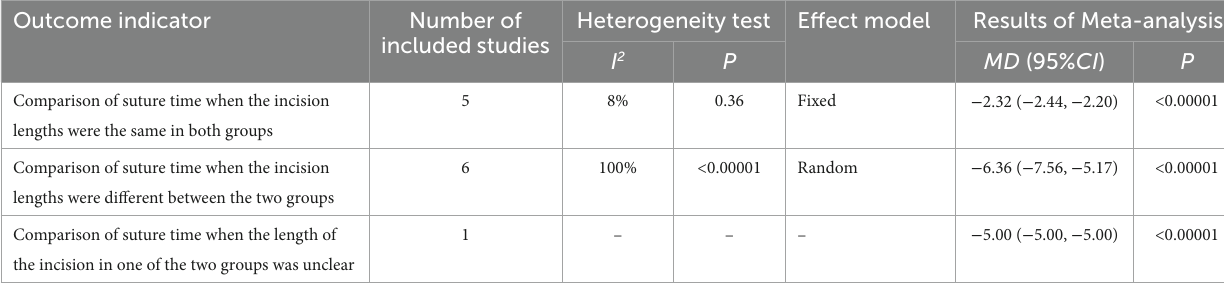
TABLE 2 Results of subgroup analysis comparing the suture time in the two